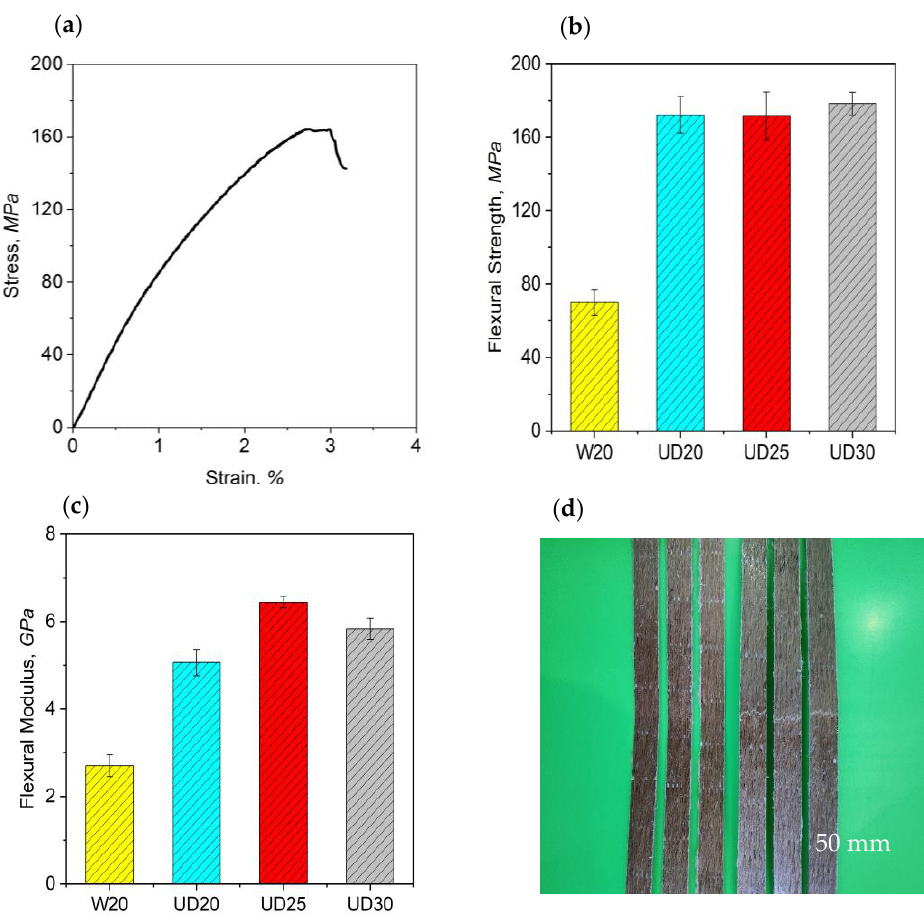
Figure 6. ( a ) Typical flexural stress–strain curve; flexural ( b ) strength and ( c ) modulus of woven and UD composites; ( d ) UD composites after flexural tests.